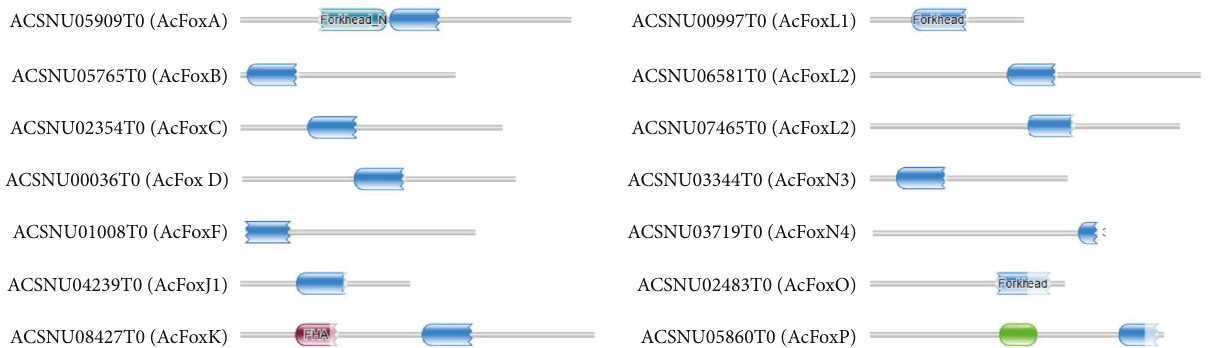
Figure 2: Structures of Fox genes in A. cerana . The putative structures of the AcFox genes consist of di ff erent numbers of exons and introns.